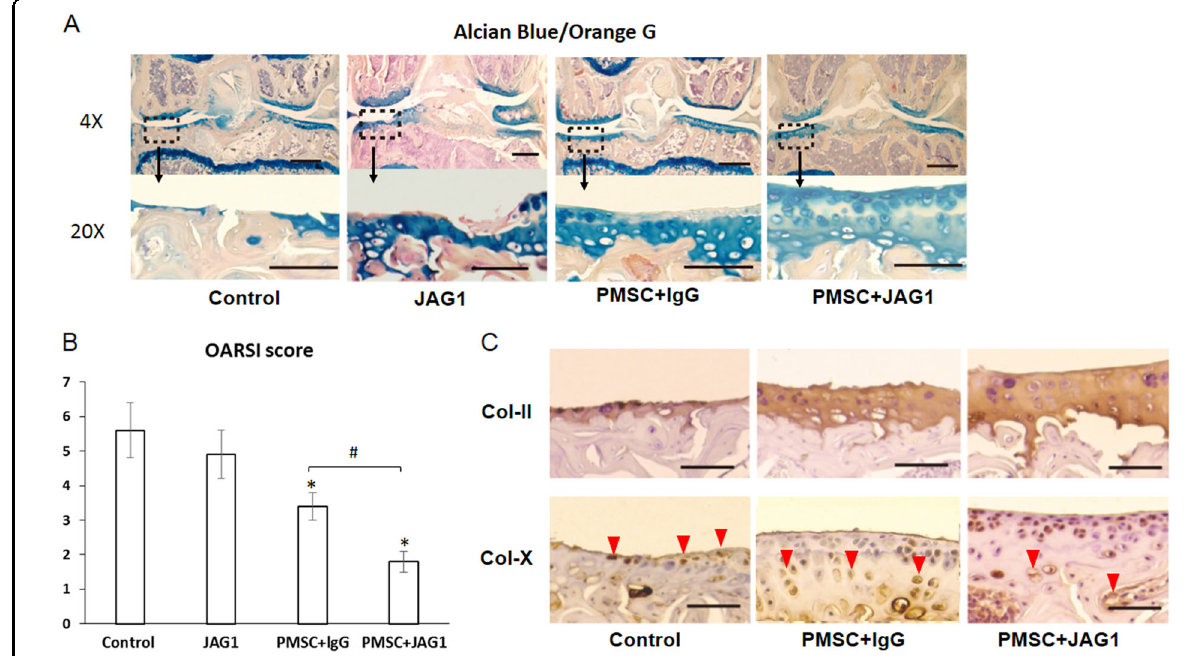
Fig. 4 Mice develop more severe osteoarthritis without PMSC injection. At week 4 post-intra-articular injection of PBS, JAG1 (10 µg/ml) in PBS, PMSCs with lgG (10 µg/ml) or JAG1 (10 µg/ml), right knee joints were harvested for histological assessment. a Representative images of medial compartment of knee sections from MLI mice with injection of PBS (Control), JAG1, PMSC + lgG and PMSC + JAG1 stained with alcian blue/orange G. b Osteoarthritic changes in knee joints ( n = 12) as quanti fi ed with Osteoarthritis Research Society International (OARSI) score. Data are the means ± SD (* p < 0.05 compared with control; # P < 0.05 between two groups). c Immunohistochemistry staining (IHC) of chondrogenic marker type II collagen (Col-ll) and type X collagen (Col-X) in tibia articular cartilage from 8-week MLI mice with or without PMSC injection. Increased Col-X expression was detected, and more Col-X-positive cells were located toward the articular surface in control and PMSC + lgG mice, not in PMSC + JAG1 mice 8-weeks after MLI surgery (Col-X positive cells: red